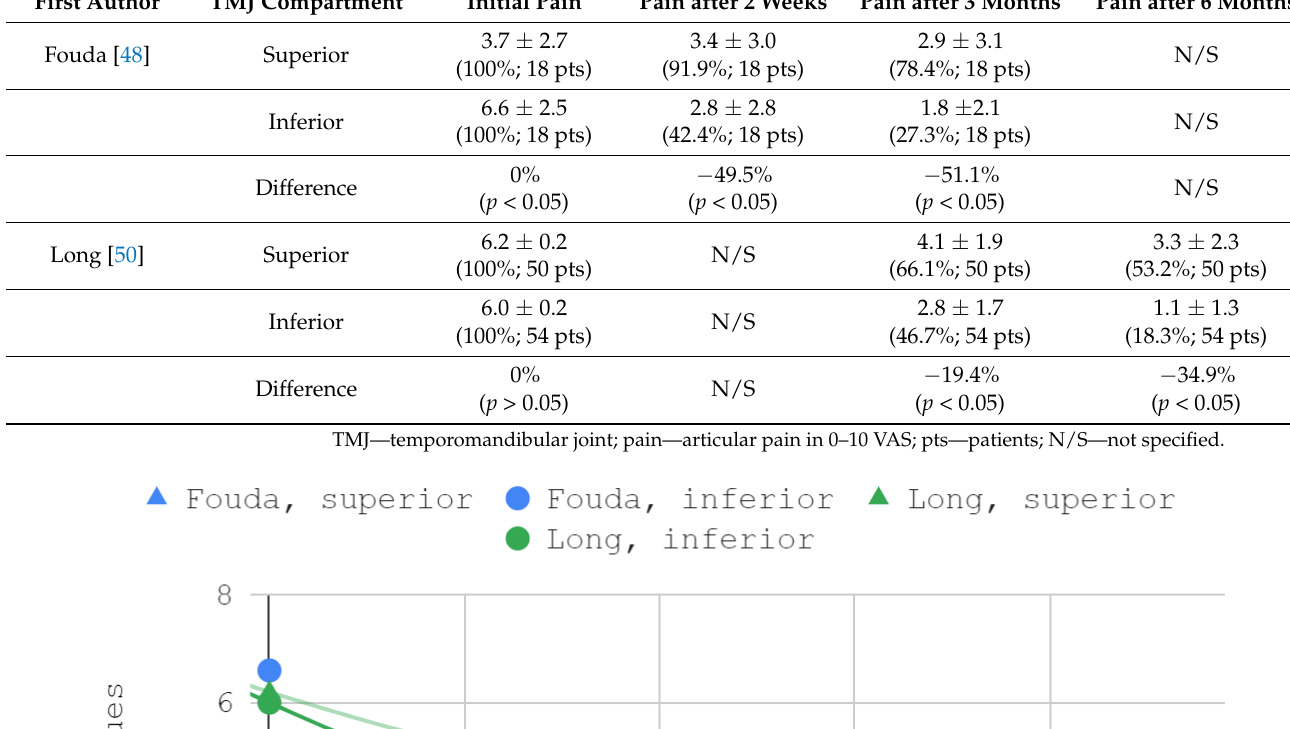
Table 4. Articular pain.